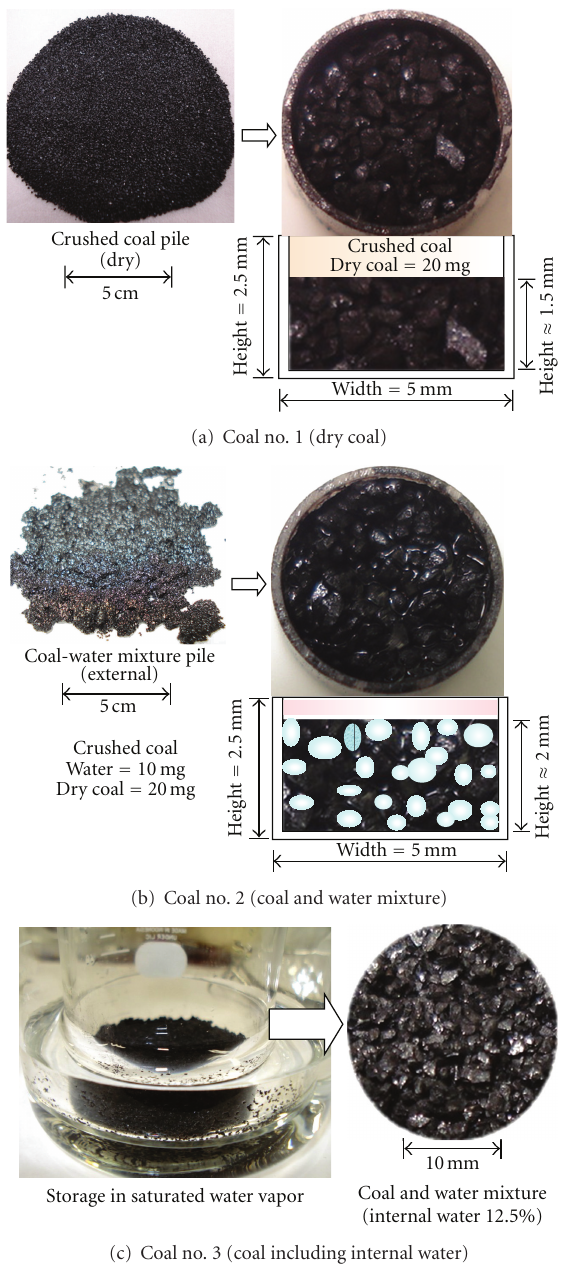
Figure 2: Three kinds of coal samples.